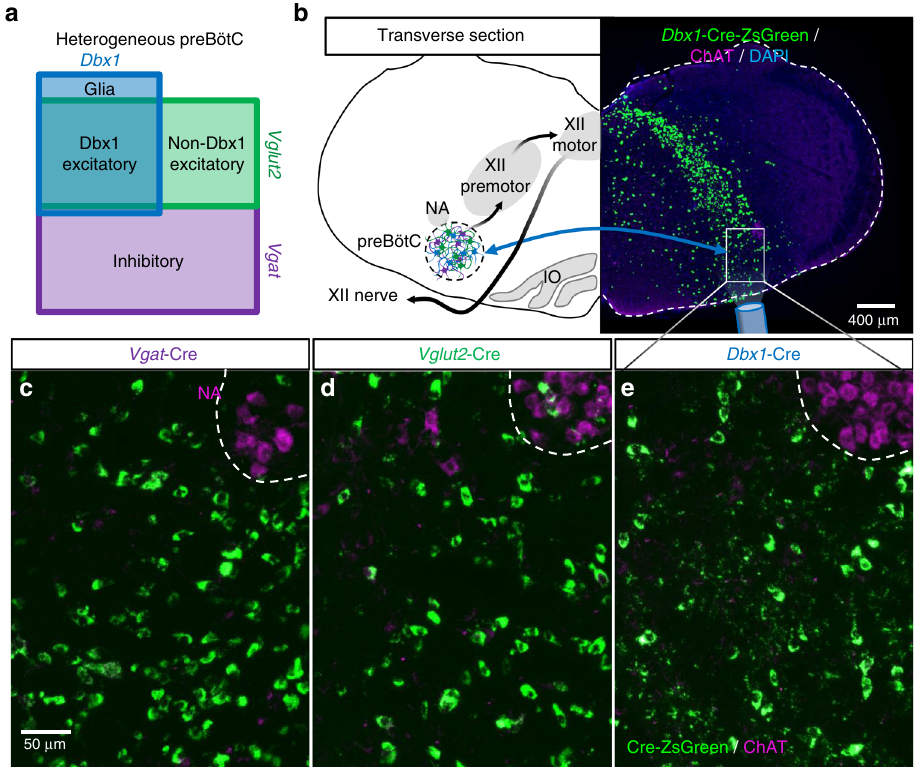
Fig. 1 Anatomy of the heterogeneous preBötC. a Diagram showing estimated ratios of Dbx1 and non-Dbx1 excitatory and inhibitory neurons 19, 24 – 26 with the corresponding promoters used to drive Cre expression within these preBötC subpopulations. b Schematic depicting key landmarks (NA nucleus amibiguus, IO inferior olive) and the pathway from preBötC rhythmogenesis to XII motor output and a representative 2.5× image of a transverse medullary preBötC section from an adult Dbx1-ZsGreen mouse. Blue arrows represent commissural connections between Dbx1 neurons 24 . c – e 20× z -projected images of Cre-dependent ZsGreen expression in preBötC neurons from Vgat Cre ( c ), Vglut2 Cre ( d ), and Dbx1 CreERT2 ( e ) mice. ChAT immuno fl uorescence demarks the NA dorsomedial to the